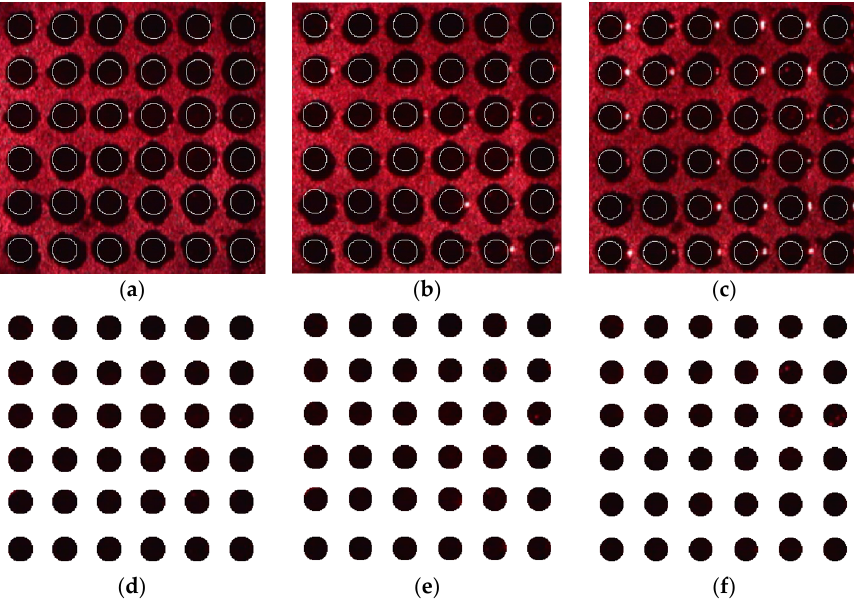
Figure 12. Segmentation results. ( a ) 0°; ( b ) 3°; ( c ) 7°; ( d ) 0°; ( e ) 3°; ( f ) 7°.